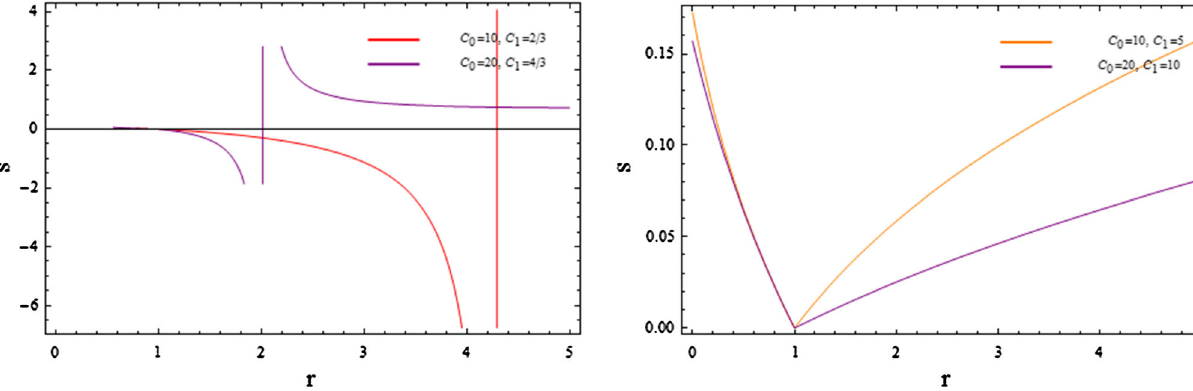
Fig. 3 The behavior of the deceleration parameter q eff ( t ) with various values of C 0 , C 1 at early time (left panel) and late time (right